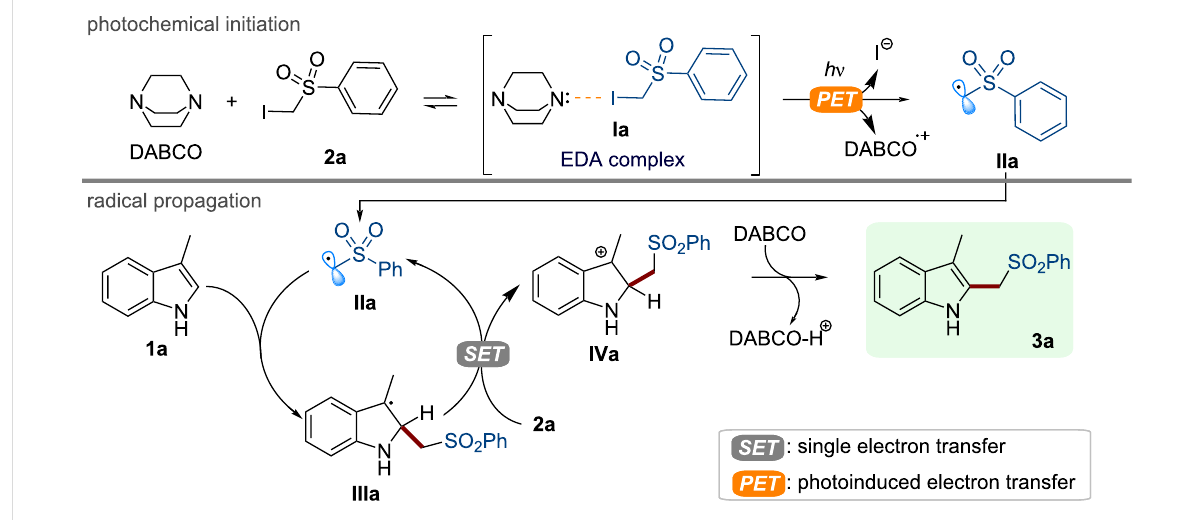
Figure 4: Proposed reaction mechanism for the photochemical alkylation of 1a with the α -iodosulfone 2a in the presence of DABCO.